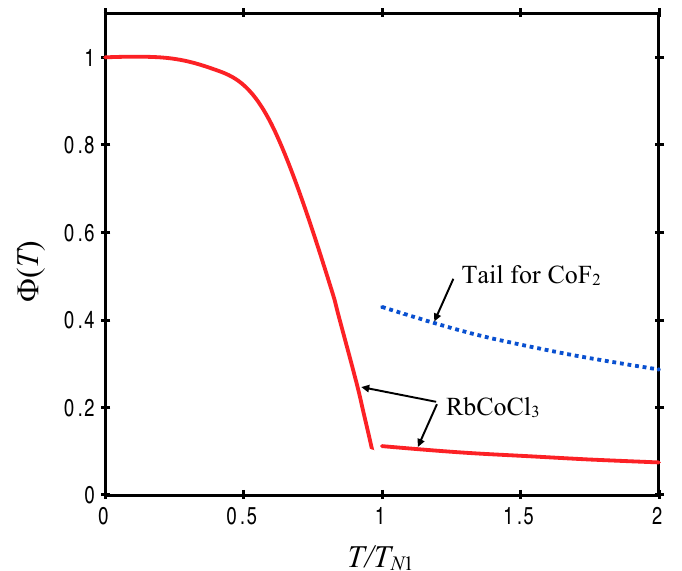
Figure 3. The T -dependence of �( T ) estimated for RbCoC1 3 at temperatures T below and above T N1 . A comparison with CoF 2 at high temperatures is also shown.